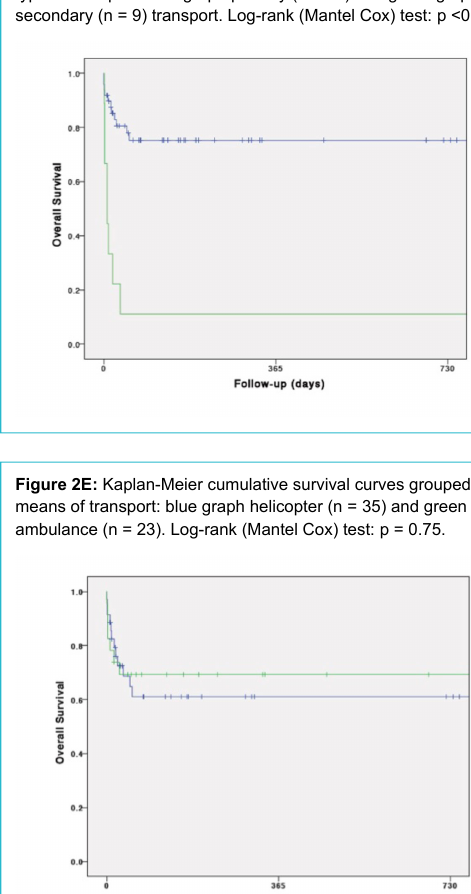
Figure 2A: Kaplan-Meier curves for overall cumulative survival curve (n = 58).